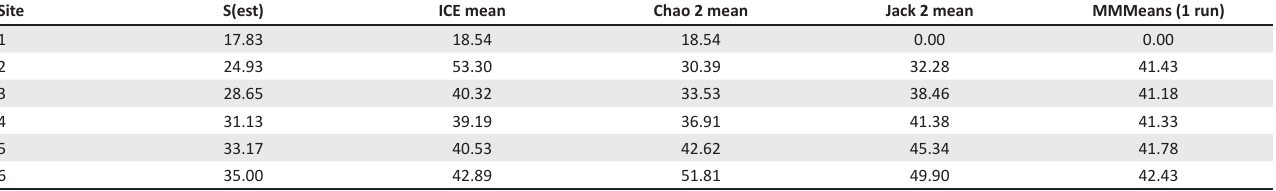
TABLE 1-A4: Richness estimator values as obtained from Estimate-S (v 9.1.0; Colwell 2013).